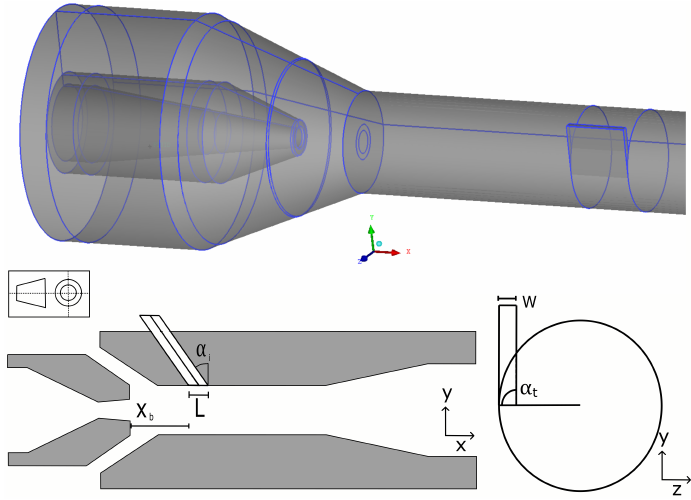
Figure 2. Generic ejector geometry with geometry parameters. Gray color signifies solid parts.